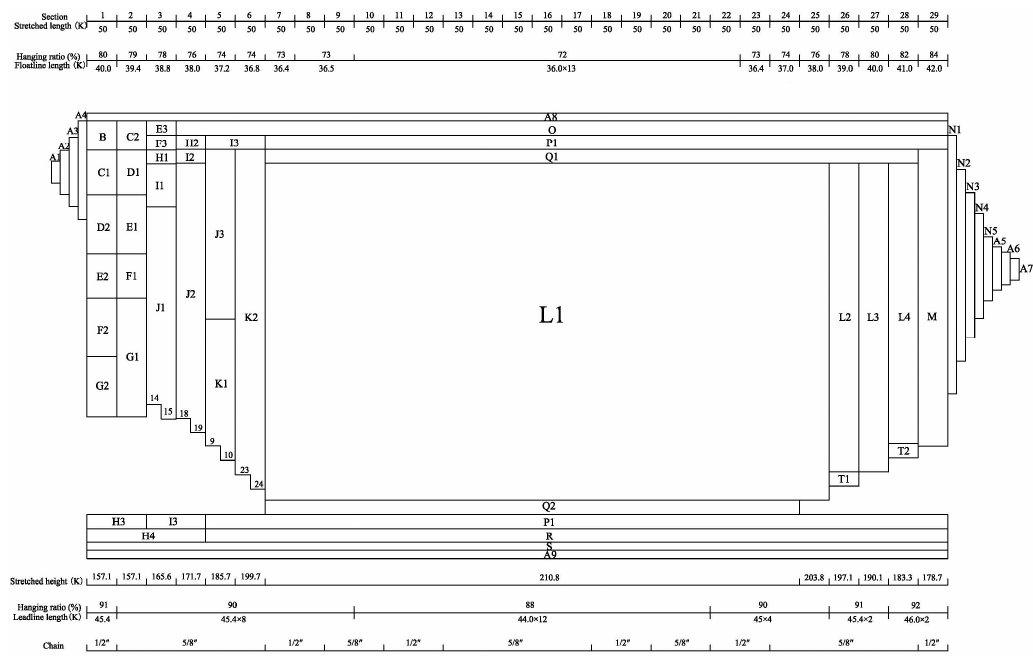
Figure 2. The net plan of the purse seine gear with 29 strips of netting panels. K is a measure of length equal to 1.515 m. Letters indicate the identifier of net panels with different mesh sizes or twine thicknesses. Table 1. Specifications for net panels for different parts of the purse seine.